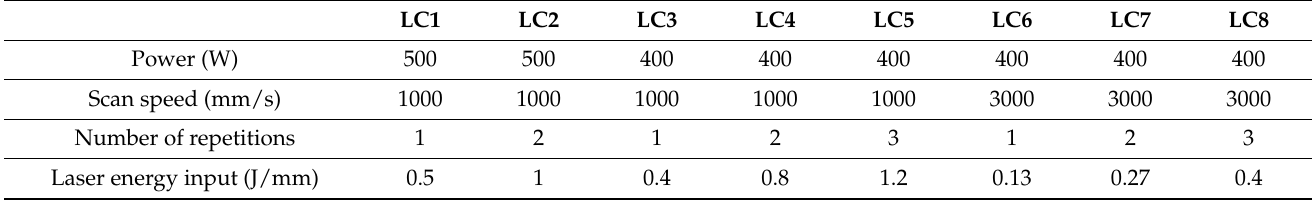
Table 1. Process parameters of laser